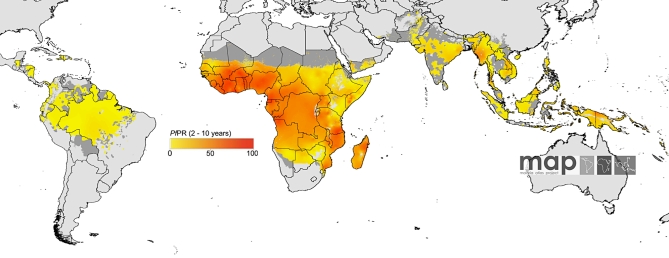
The Spatial Distribution of P. falciparum Malaria EndemicityThe data are the model-based geostatistical point estimates of the annual mean PfPR2−10 for 2007 within the stable spatial limits of P. falciparum malaria transmission, displayed as a continuum of yellow to red from 0%–100% (see map legend). The rest of the land area was defined as unstable risk (medium grey areas, where PfAPI < 0.1 per 1,000 pa) or no risk (light grey, where PfAPI = 0 per 1,000 pa) [17–19].